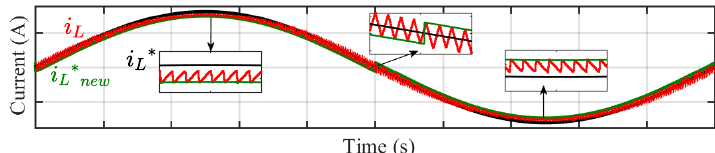
Figure 10. Inductor current obtained with the fixed offset corrected reference.